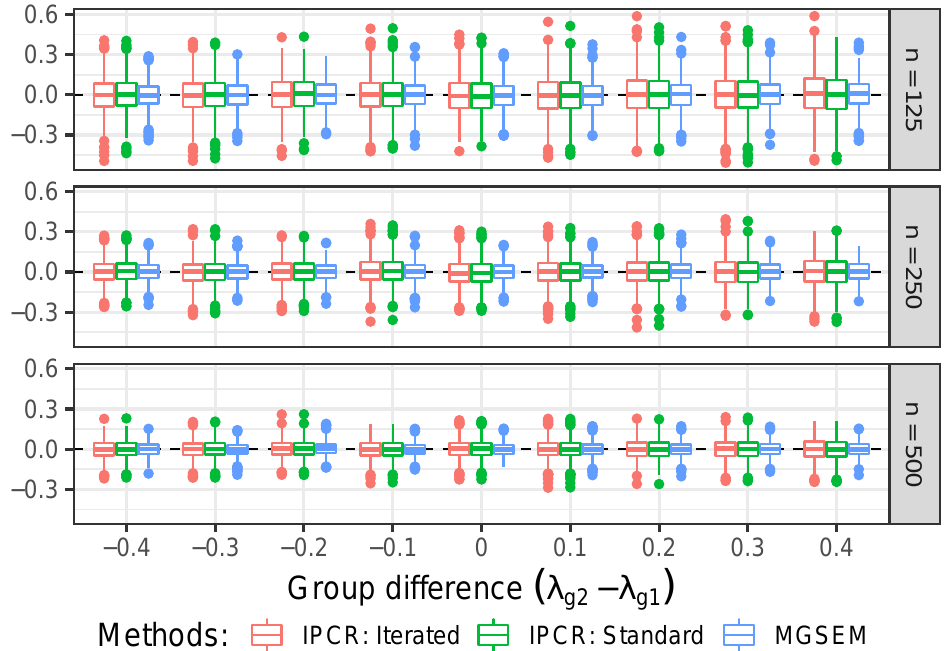
Figure 9. Boxplots with the bias of the estimated group difference in the factor loading λ ( y -axis) for different true group differences and sample